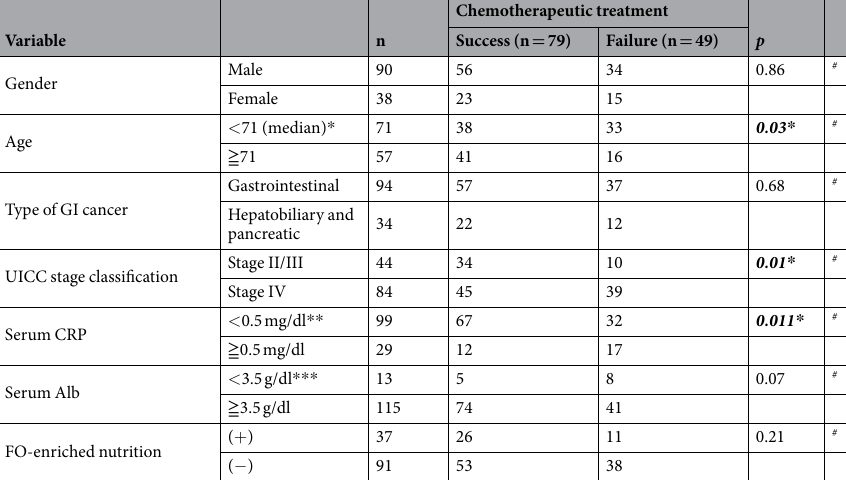
Table 1. Association between tolerance to chemotherapy and clinicopathological factors in GI cancer patients. * The median age at treatment was 71 years in the total cohort. # Chi-square test. * p < 0.05 . ** The cut - off value for serum CRP level was 0.5 mg/dl. *** The cut-off value for serum Alb level was 3.5